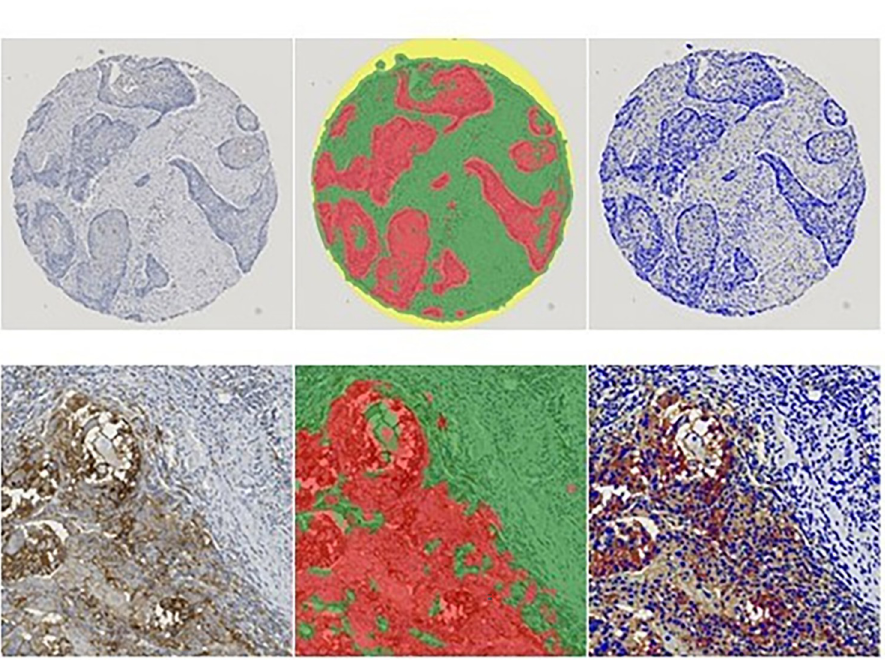
Fig 1. Top row: Representation of the complete core. Bottom row: section of the core, left: PD-L1 staining(20 fold magnification). Middle: Classifier shows stromal cells (green), tumor cells (red), microscope slides (yellow). Right: The computer-aided analysis counts the cells involved based on the cell nuclei (dark blue) and differentiates the colored cells based on the membrane staining, subdivided according to intensity (yellow, orange, red).